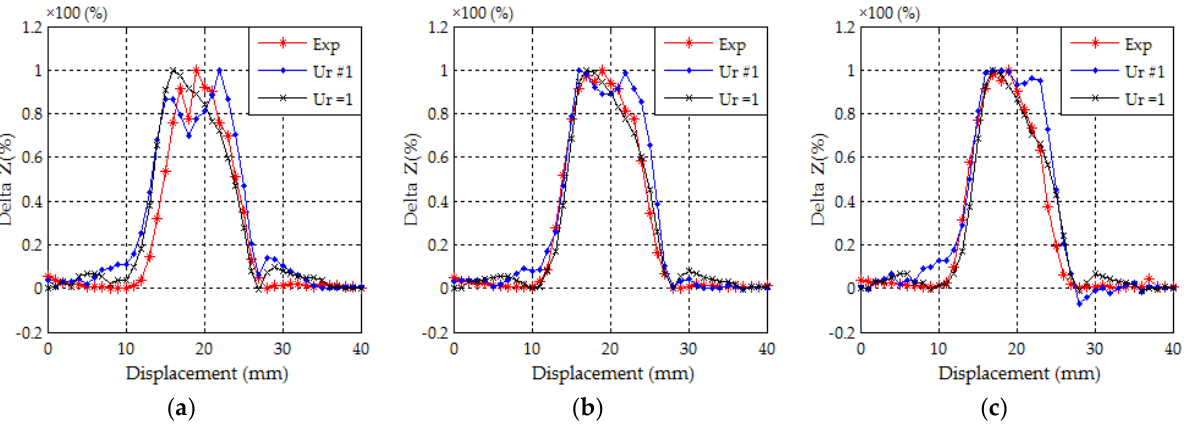
Figure 9. Impedance variation in (%) at 20 kHz with ( a ) depth = 0.3 mm, ( b ) depth = 0.5 mm, and ( c ) depth = 1 mm.